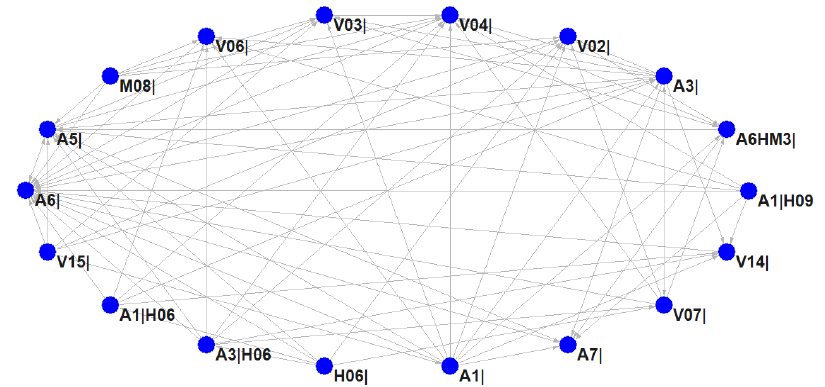
Figure 9. Relationships among 18 nodes in Cluster 6.